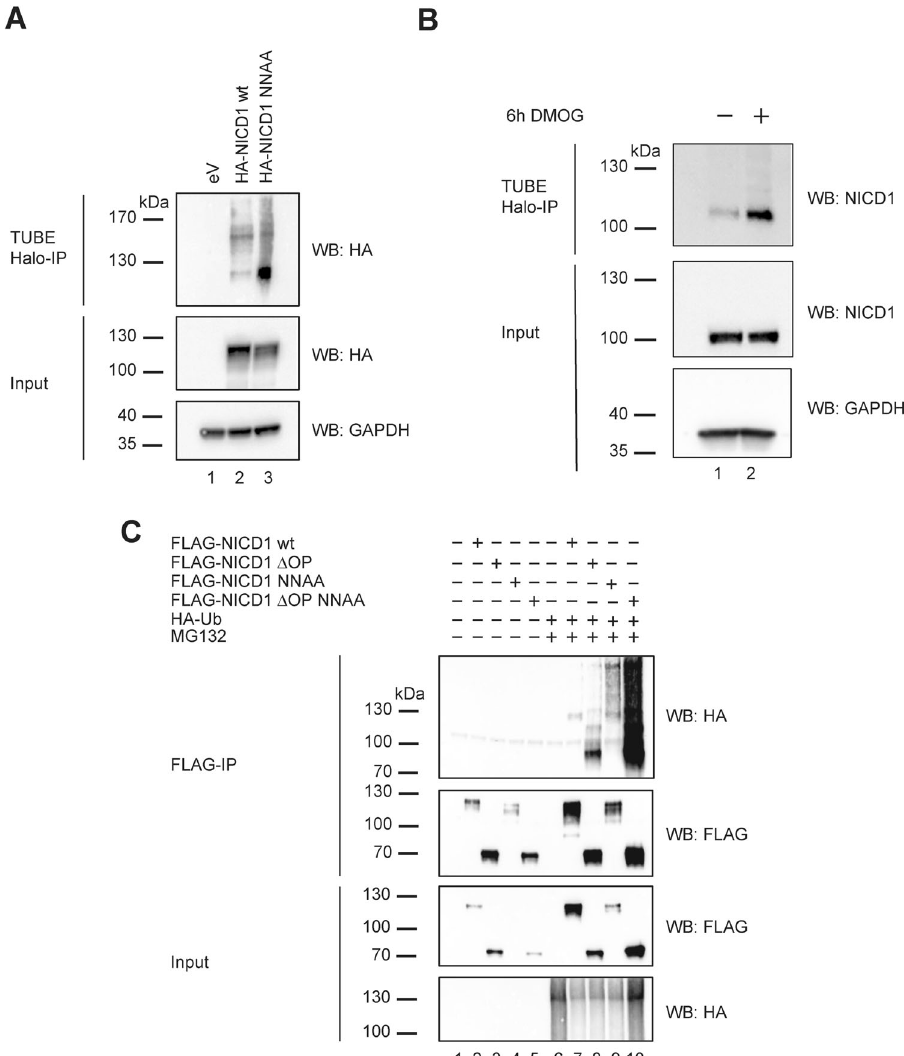
Fig. 5 Hypoxia increases NICD1 ubiquitination. A NICD1 NNAA mutant is more ubiquitinated compared to the NICD1 wild-type. Phoenix TM cells were transfected with plasmids encoding for HA-tagged NICD1 wild-type (wt), HA-tagged NICD1 NNAA mutant, or an empty vector as